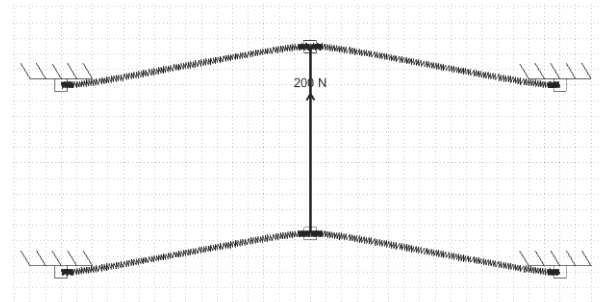
Figure 11. A typical compound multibeam parallelogram mecha- nism loaded at the primary